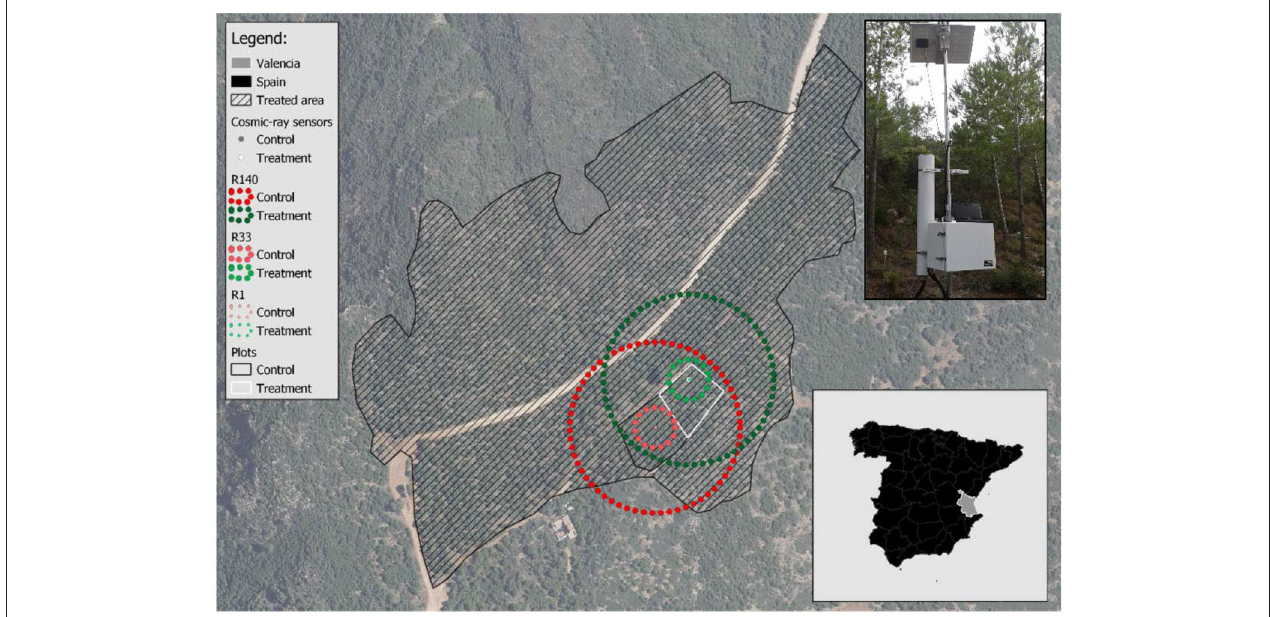
FIGURE 1 | The experimental site within the “Sierra Calderona” Natural Park (Valencia, Spain). The dashed area indicates the treated area in 2012. R1, R33, and R140 indicate soil samplings with radii of 1, 33, and 140m, respectively. The control and treatment plots are indicated by black and white line, respectively. The picture in the upper right shows one of the CRNP